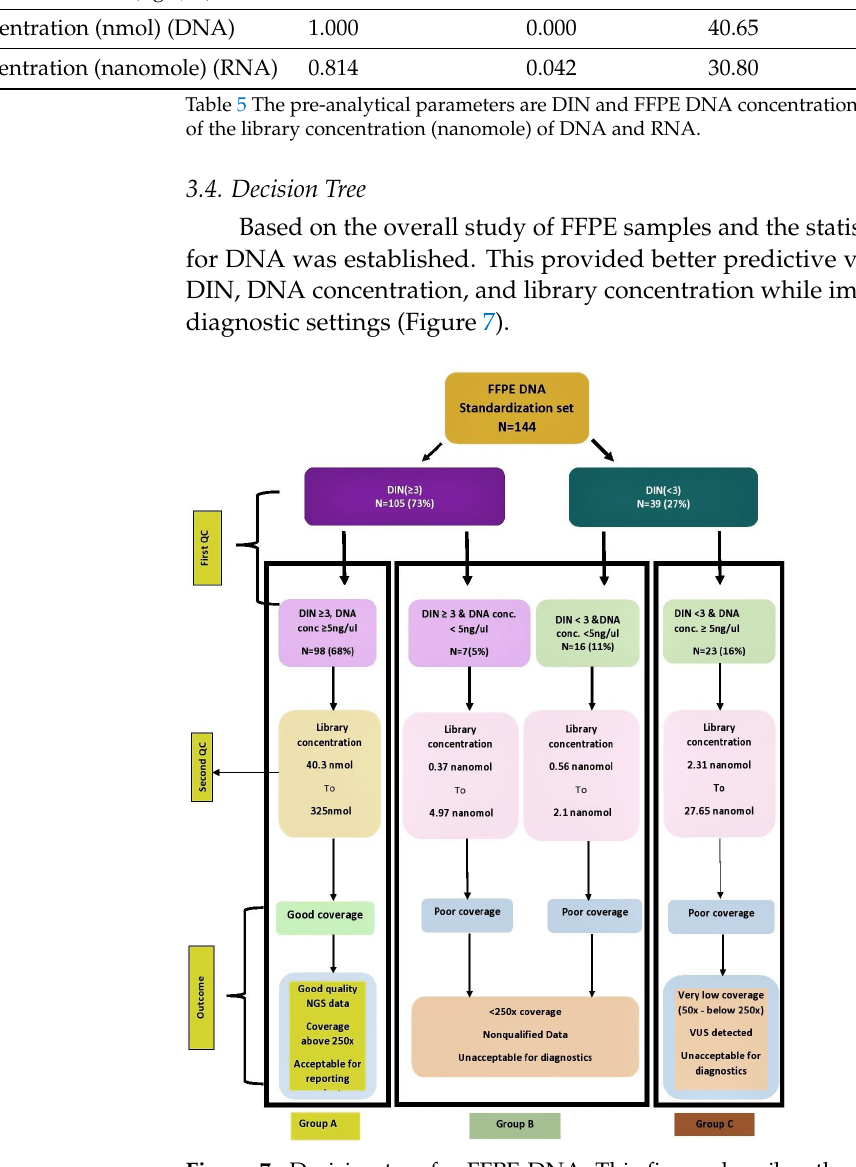
Table 5. The cut-off value of pre-analytical and post-analytical parameters for FFPE DNA and RNA. Area under Curve Parameters